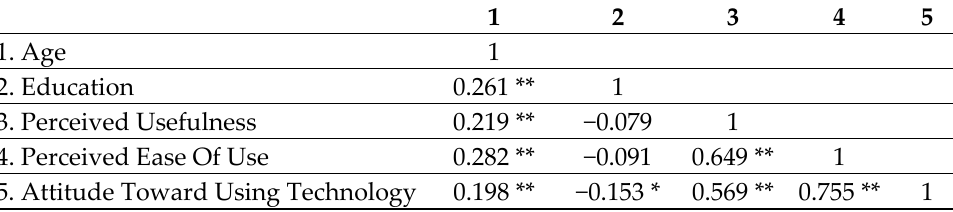
Table 5. Correlation analysis.